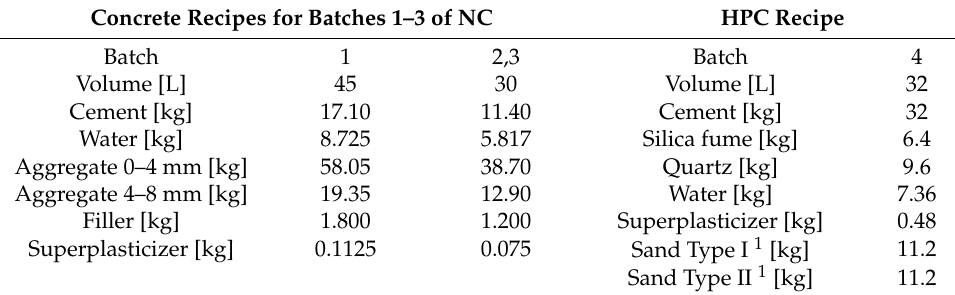
Table 1. Normal concrete and HPC recipes.